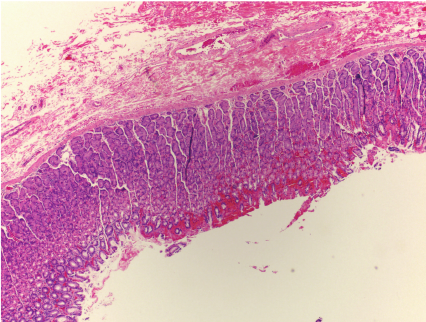
Figure 1: Computed tomography of intra-abdominal cysts. Arrows point to multiple cysts arising from the stomach wall (axial).